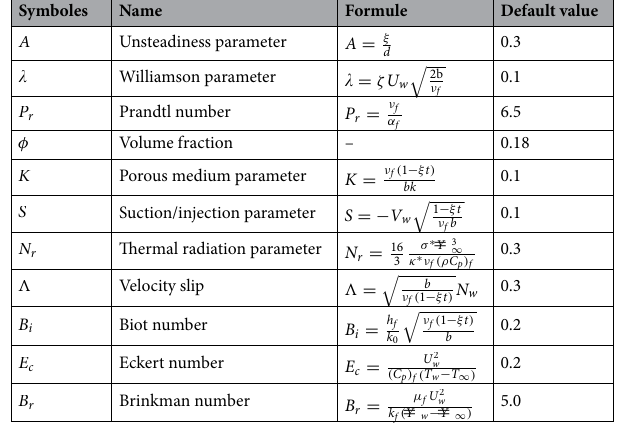
Table 4. Clarification of entrenched control